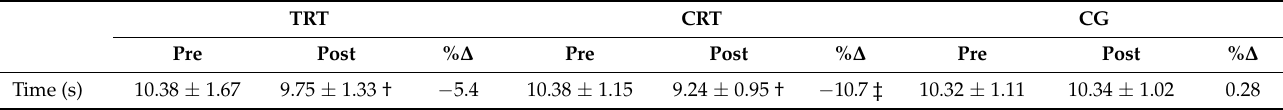
Table 3. Timed Up and Go data. Values are given as mean ±